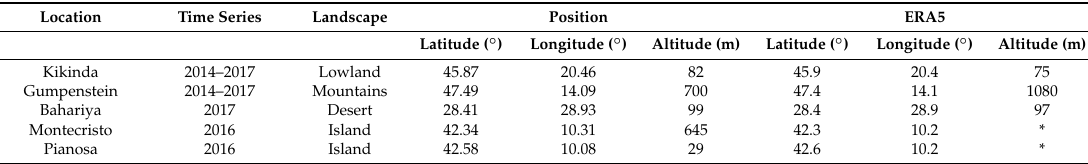
Table 1. Locations used in the study (* see surface on